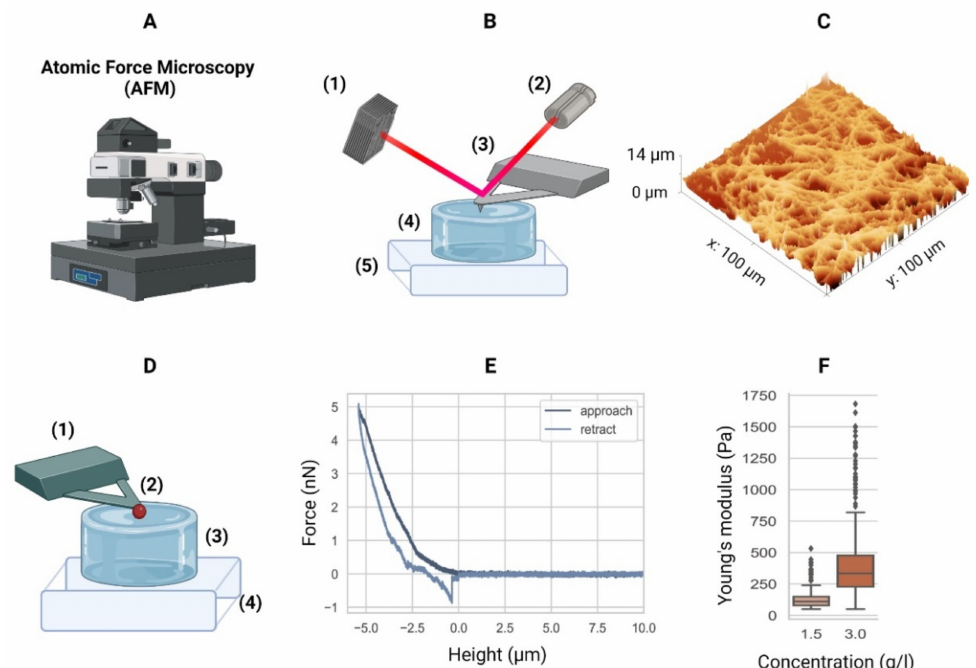
Figure 6. Atomic force microscopy. ( A ) Equipment. ( B ) Schematic of an AFM setup with a four- quadrant photodiode (1), in which the four-quadrant photodiode (1) receives a laser (2) reflected from a cantilever (3), in this case positioned over a hydrogel (4) mounted in a piezo stage (5). For example, the height differences in a sample (4) are measured by adjusting the stage using piezo elements (5) to counter the cantilever bending on a nanometer scale. ( C ) The AFM can then generate a surface heightmap of the hydrogels such as a GelMA hydrogel (shown). AFM can also be used to determine the mechanical properties of hydrogels. ( D ) Schematic of the AFM technique to determine the elastic moduli of hydrogels with a tipless cantilever (1), spheroidal probe (2, red), hydrogel (3), and stiff substrate (4). As the cantilever represents a spring with a known spring constant, the cantilever bending due to elastic counterforces exerted by the soft material is correlated with the piezo stage height (4). ( E ) The so-called force–distance curves are recorded. Data from a collagen type-I hydrogel (3.0 g/L) are shown. ( F ) Young’s moduli of a 1.5 g/L and 3.0 g/L collagen type-I hydrogel.